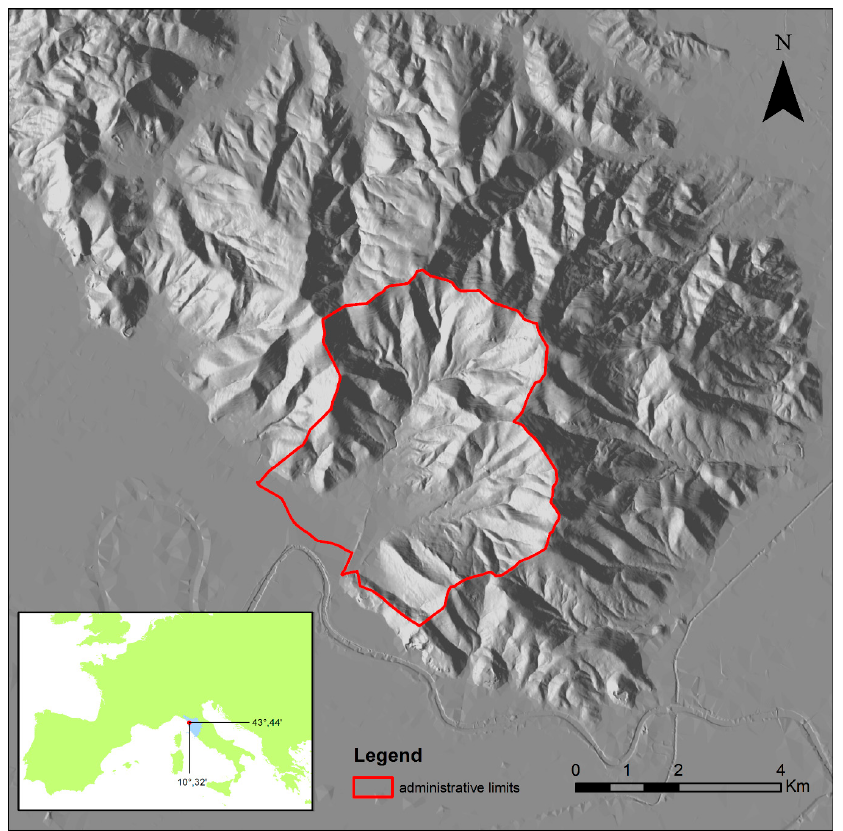
Figure 1. Overview of the study area. The municipality of Calci, Pisa, Tuscany Region,